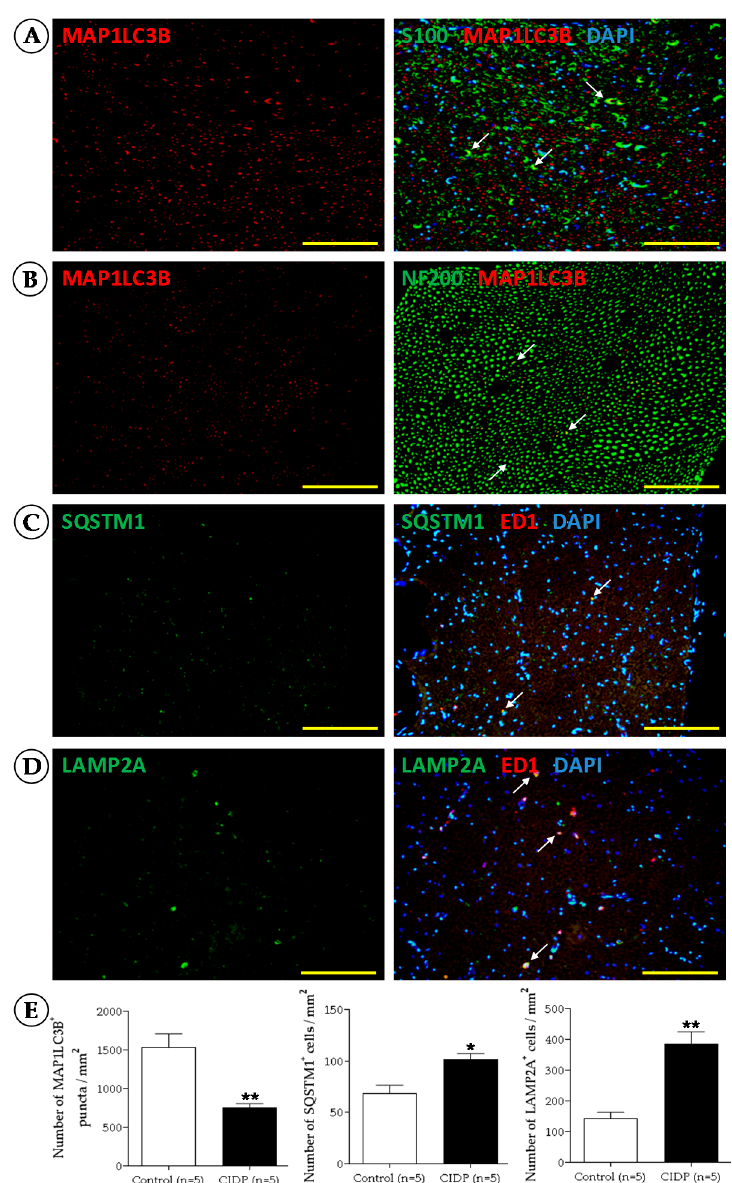
Figure 3. Representative immunofluorescence micrographs from transverse sections of sciatic nerve from an adult Lewis rat. ( A ) Staining of MAP1LC3B (red) and double staining of MAP1LC3B (red) with S100 positive Schwann cells (green); ( B ) Staining of MAP1LC3B (red) and double staining of MAP1LC3B (red) with neurofilament 200 positive nerve fibers (green); ( C ) Staining of SQSTM1 (green) and double staining of SQSTM1 (green) with macrophages (red); ( D ) Staining of LAMP2A (green) and double staining of LAMP2A (green) with macrophages (red). Nuclei are counterstained with DAPI (blue). White arrows show double staining. Yellow bar = 50 μ m; ( E ) Analyses of staining are represented by histograms. Mean values and SEM are indicated; * p < 0.05, ** p < 0.01 compared to control.